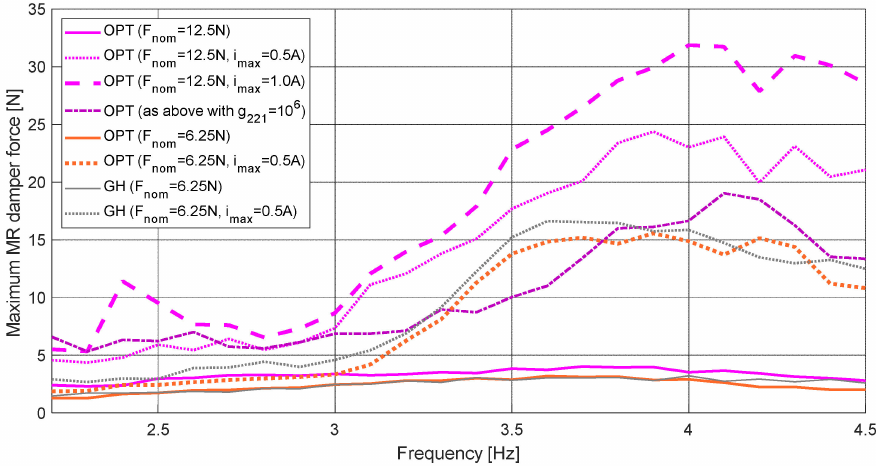
Figure 13. The maximum MR damper force frequency characteristics: OPT for different control parameter values vs. GH for F nom = 6.25